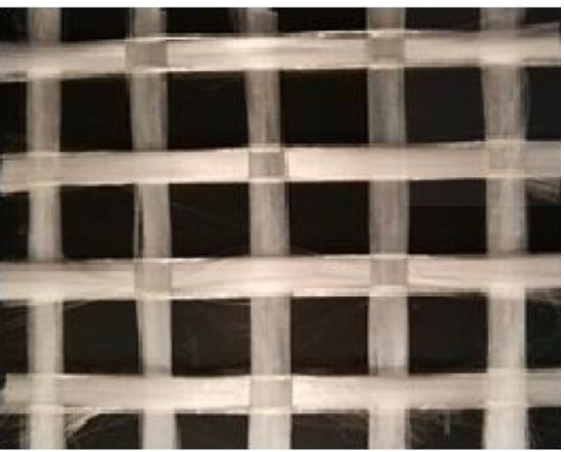
Figure 1. Alkali-resistant (AR) glass fiber with mesh size of 12 × 12 mm.